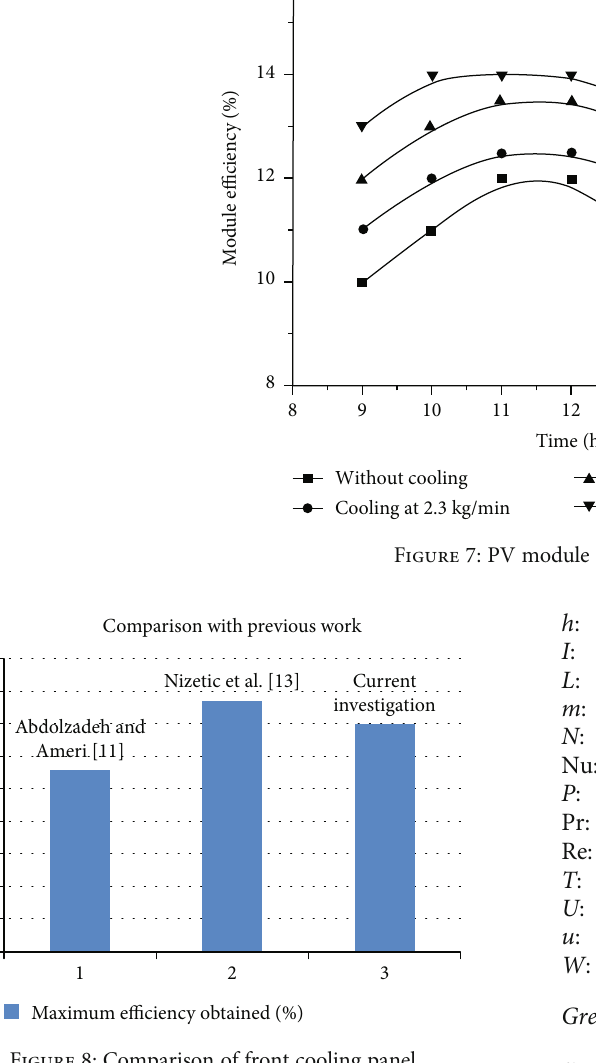
Figure 8: Comparison of front cooling